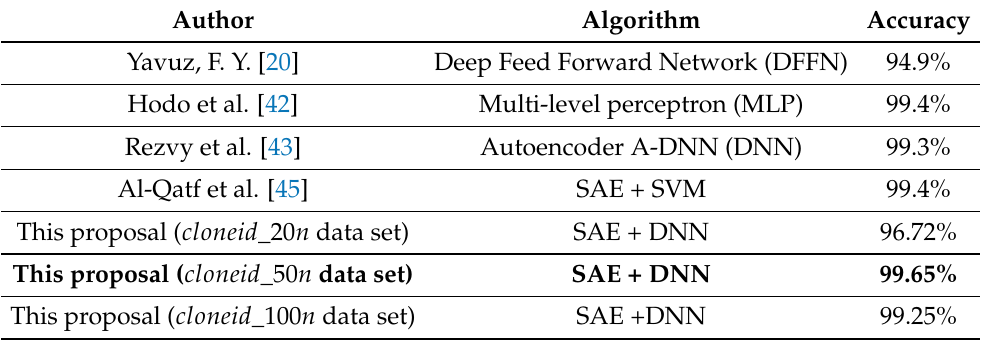
Table 13. Comparison with well-known works that presented ML approaches to classify security threats in IoT environments.